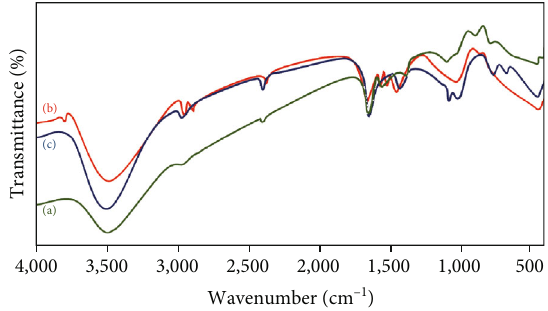
Figure 4: Infrared spectra of (a) virgin epoxy coating, (b) 5% titanium-embedded epoxy coating, and (c) 10% titanium- embedded epoxy coating before natural exposure testing at NIO.